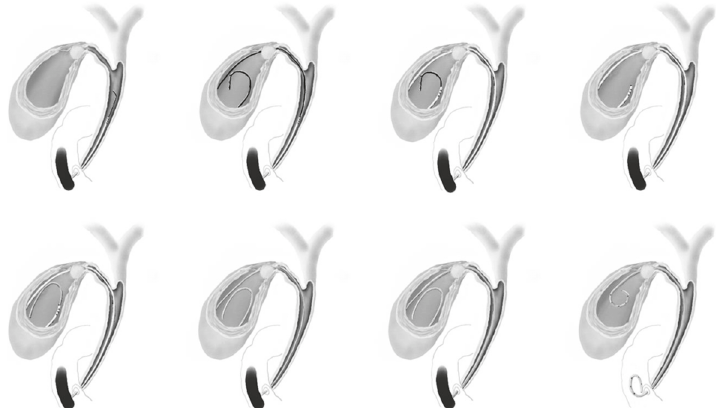
Figure 1: Depiction of the procedure for endoscopic stenting of the common bile duct and gallbladder. A catheter is inserted deep into the bile duct and a guidewire advanced into the cystic duct and gallbladder. The catheter is inserted over the guidewire up to the fundus of the gallbladder. A double-pigtail polyethylene stent is then inserted.